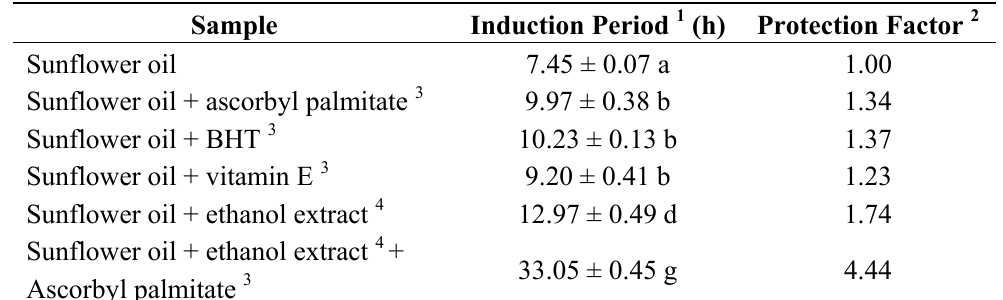
synthetic and natural antioxidant 1